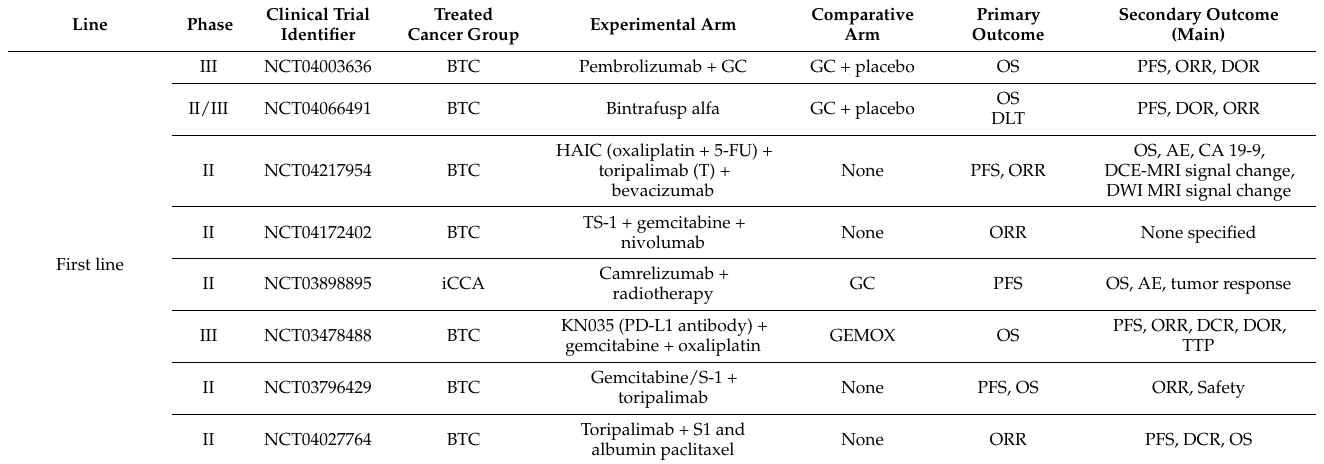
Table 3. Ongoing trials with immunotherapy in biliary tract